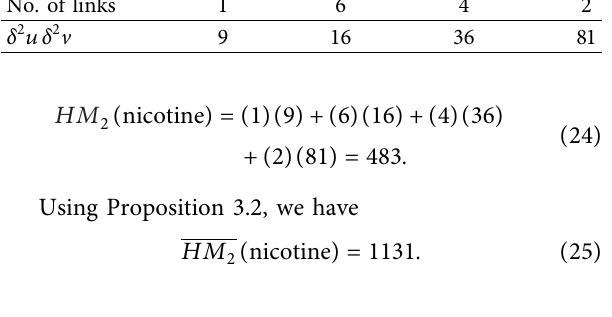
Table 6: Links dataset of the graph structure of nicotine. No. of